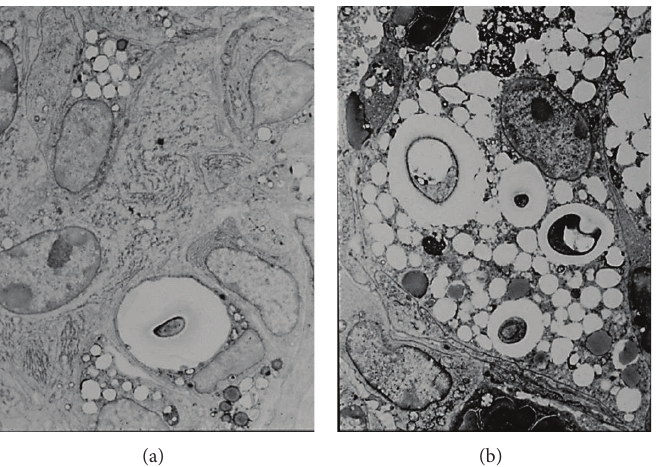
Figure 3: (a) An ultrastructural examination of the macrophage in mice infected with C. neoformans TIMM 0362 showed that a large number ofphagocytizedlipiddropletsandasmallnumberoftheyeasts,aswellaslesserdevelopedorganelles.(b)Anultrastructuralexaminationofthe macrophage in mice infected with C. neoformans TIMM 0372 showed a large number of developed organelles, including rough endoplasmic reticulum and